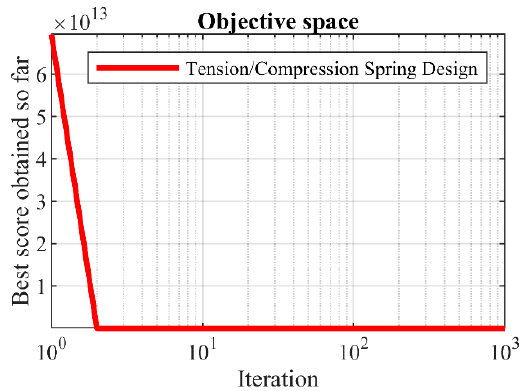
Figure 15. SOA’s performance convergence curve on the tension/compression spring.